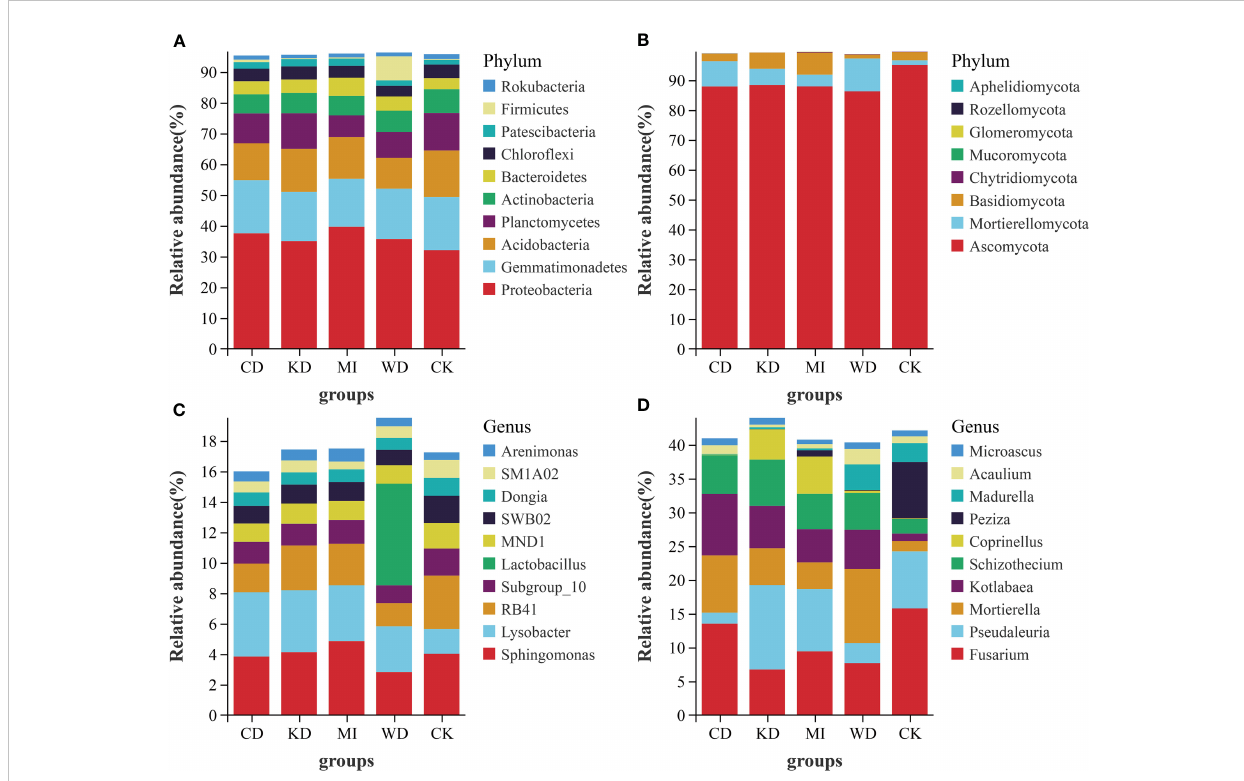
FIGURE 2 Relative abundance at phylum and genus level of soil microbial community of intercropping systems (top 10 shown). (A) bacteria phylum level; (B) fungi phylum level; (C) bacteria genus level; (D) fungi genus level. WD, watermelon-daylily intercropping; CD, cabbage-daylily intercropping; KD, kale-daylily intercropping; MI, row mixed intercropping, watermelon, cabbage, and kale were alternately intercropped with daylily; CK, monoculture